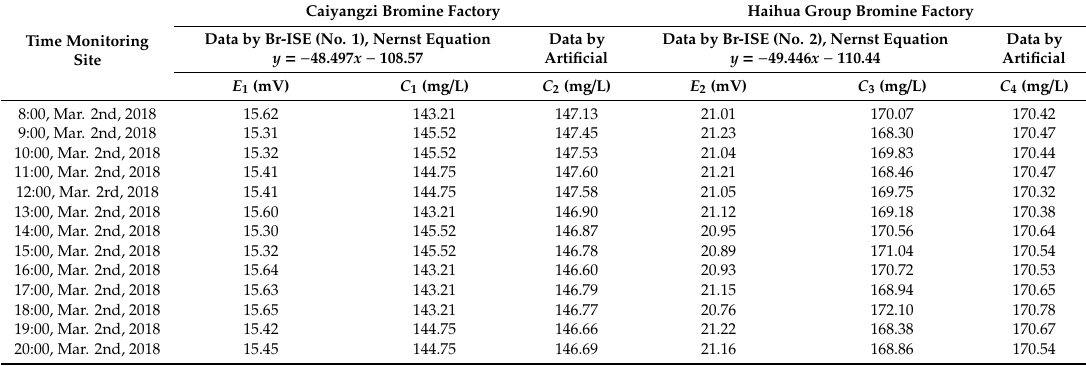
Table 3. On-site real-time monitoring data of bromide electrodes.